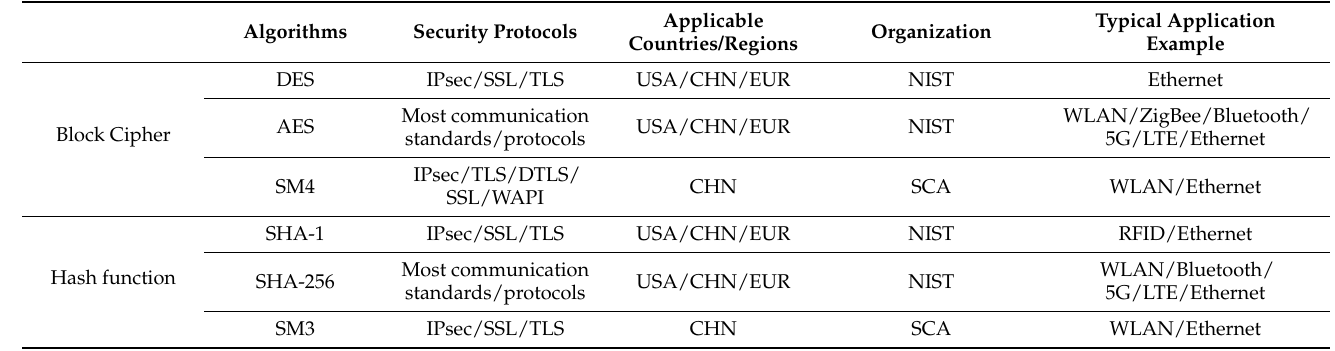
Table 1. Major algorithms in block ciphers and hash